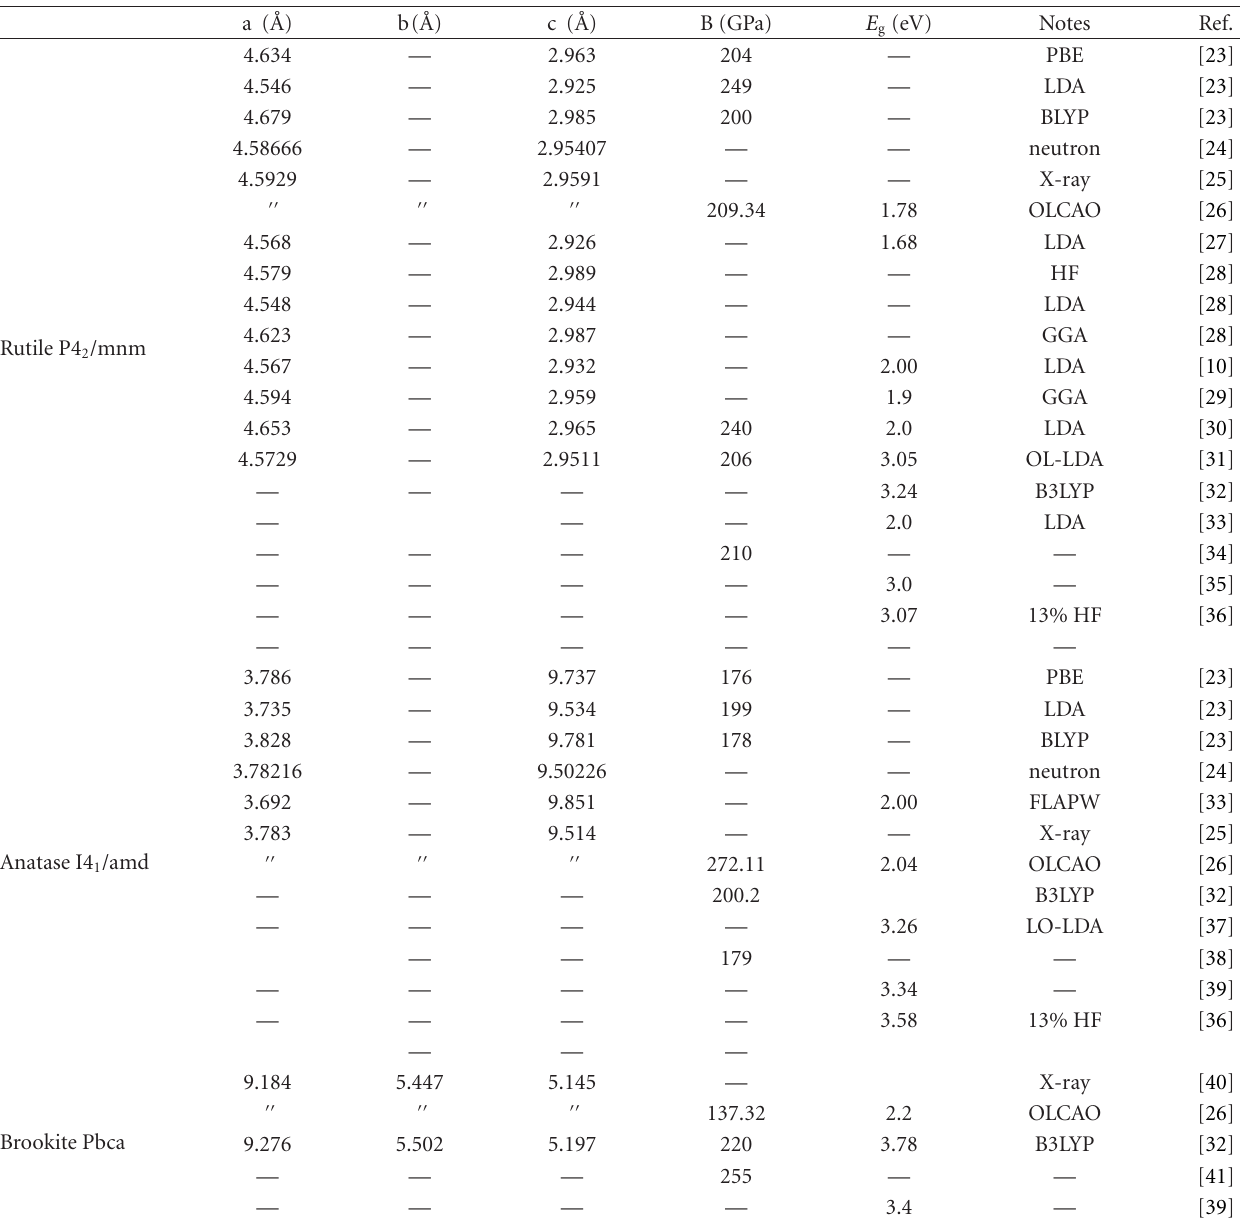
Table 1: Crystalline lattice parameters, bulk modulus (B), and band gap E g of TiO 2 polymorphs. HF: Hartree-Fock, PBE [18], BLYP [19, 20], B3LYP [21, 22], OLCAO: Orthogonalized Linear Combination of Atomic Orbitals, FLAPW: full potential linearized augmented plane wave